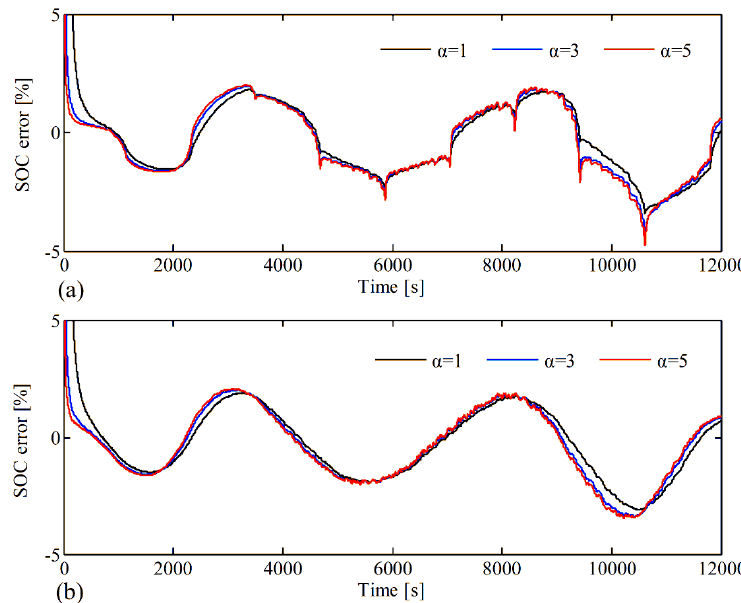
Figure 10. SOC estimation error of AGNO with different scale factors: ( a ) NEDC test; and ( b ) FUDS test.